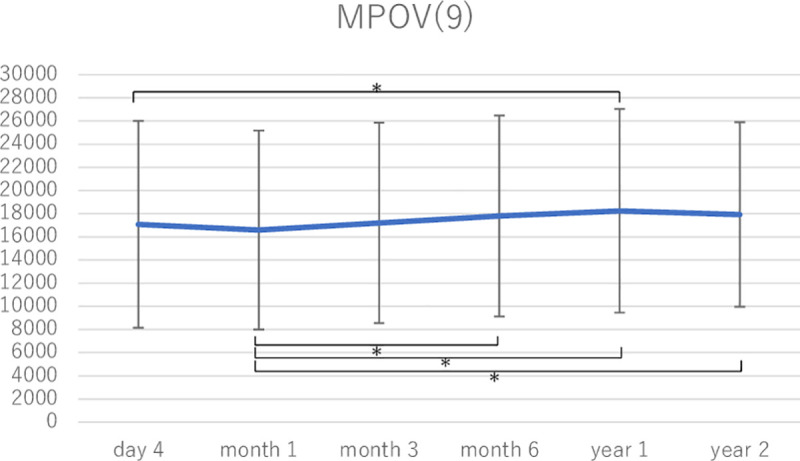
A change in macular pigment optical density volume (MPOV) within 9° eccentricity in the eyes that had all measurement data during a postoperative follow-up period of 2 years (35 eyes of 22 subjects).Asterisks indicate a significant difference (p < 0.05) in MPOV between two time points.